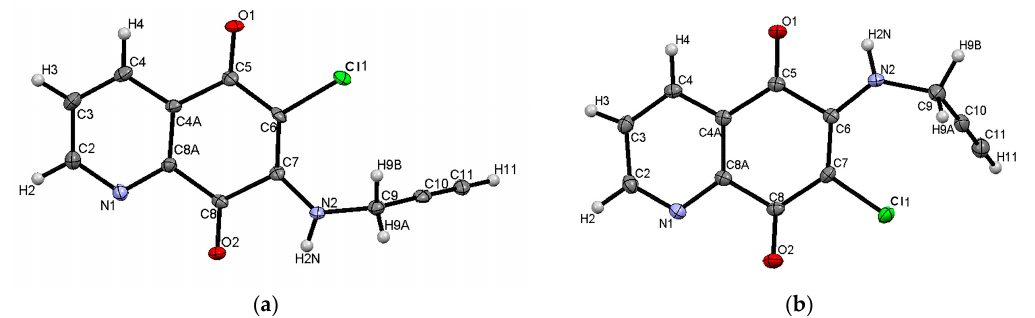
Figure 1. Molecular structures with atom numbering of ( a ) 6-chloro-7-propargylamine-5,8-